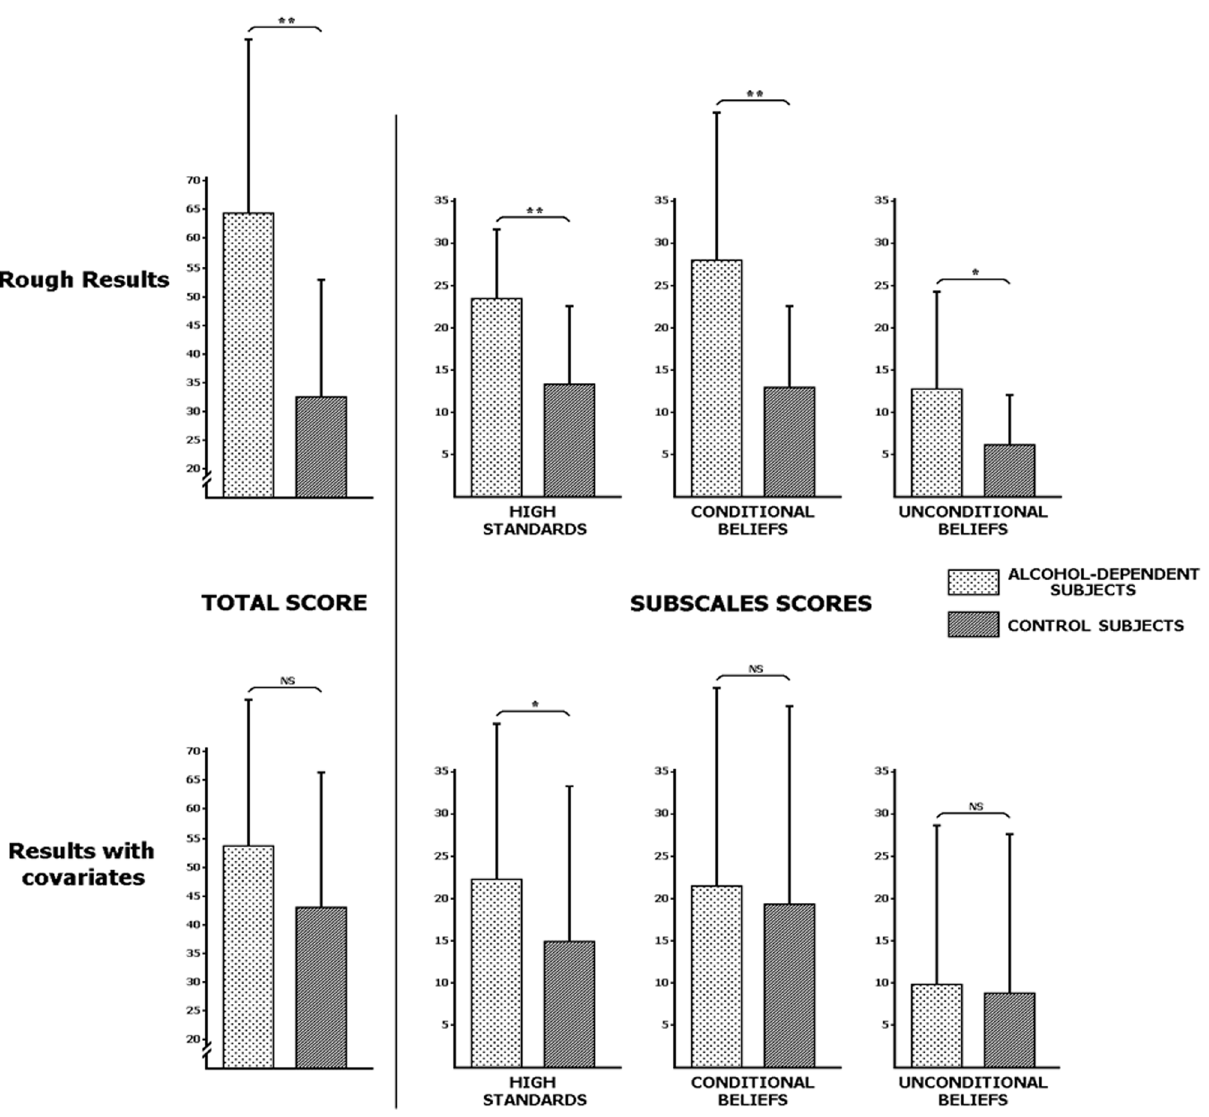
Figure 1. Self-Beliefs Social Anxiety Scale results for each group (alcohol-dependent and control subjects). Global scores are presented on the left and the scores for each subscale (high standards, conditional beliefs and unconditional beliefs) are presented on the right. The upper part depicts rough scores and the lower part depicts the scores corrected for depression (BDI score), anxiety (STAI A and B scores) and social anxiety (FNE and LSAS scores) using covariance analyses. Covariates appearing in the model are evaluated at the following values: 10.82 for BDI, 34.37 for STAI A, 40 for STAI B, 22.89 for LSAS and 14.47 for FNE. NS=Non-significant;*p , .01;**p , .001.